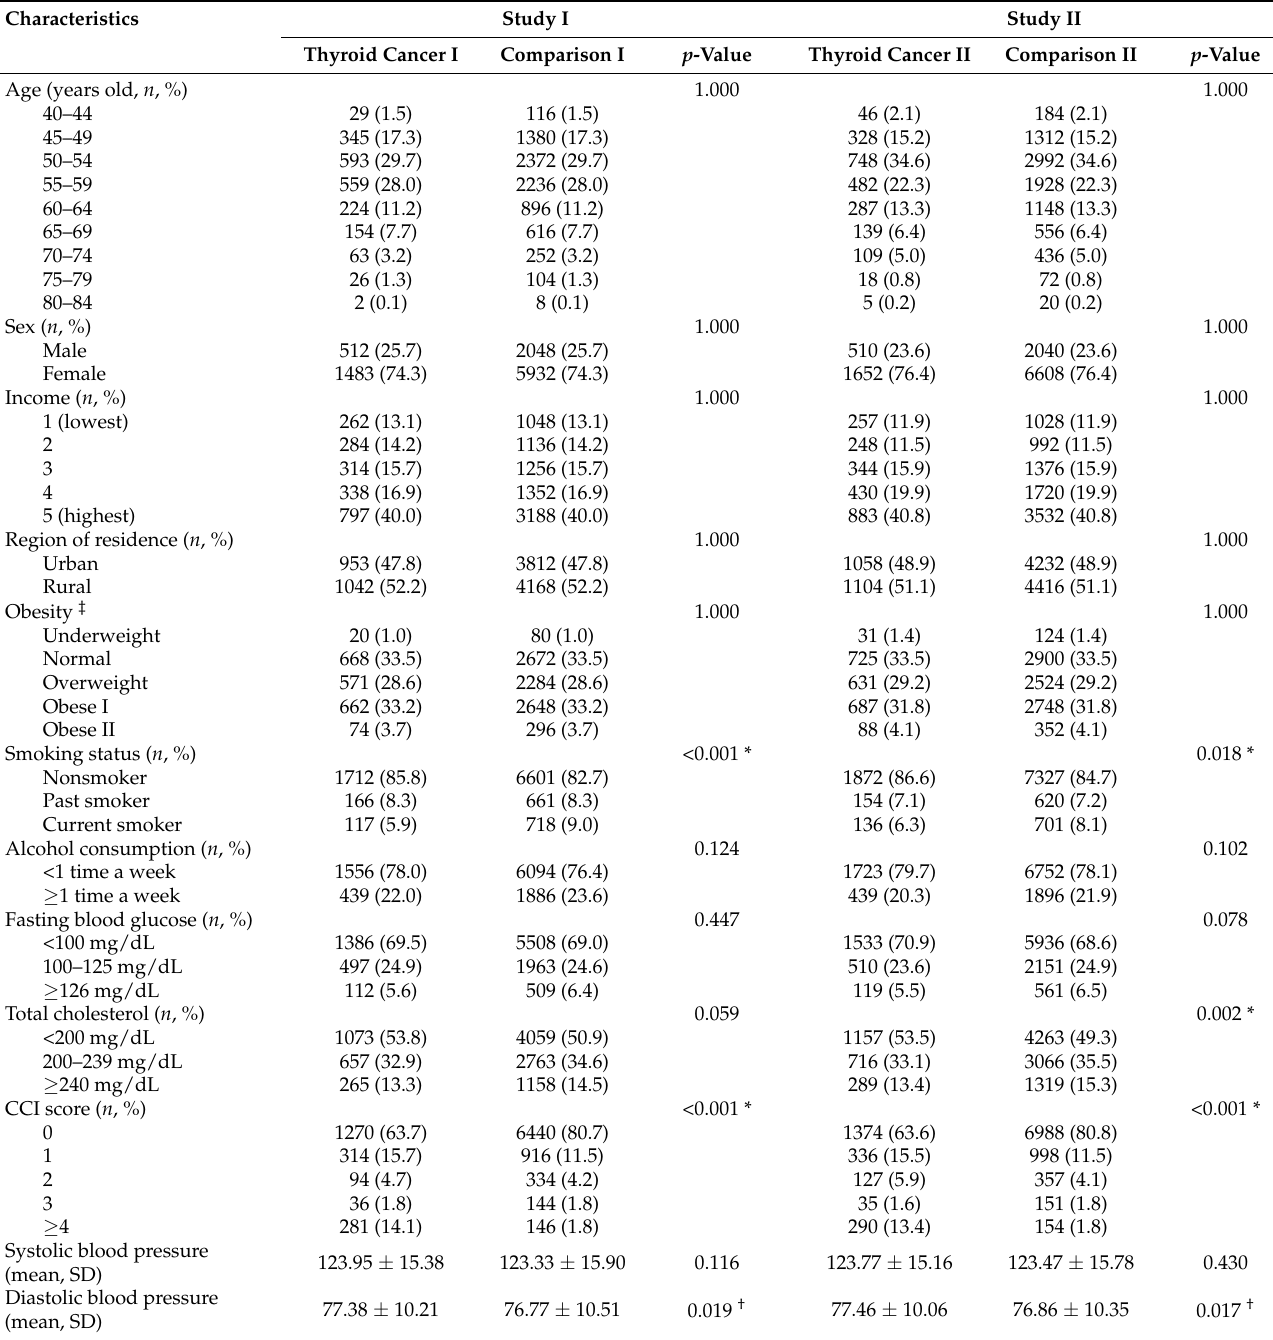
Table 1. General characteristics of